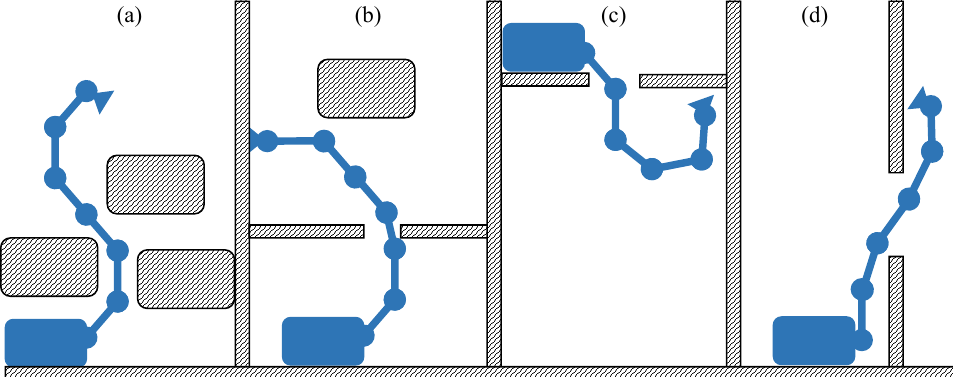
Figure 1. Possible inspection scenarios: ( a ) moving around obstacles ( b ) entering through a small entrance ( c ) under-ground inspection ( d ) wall side inspection.